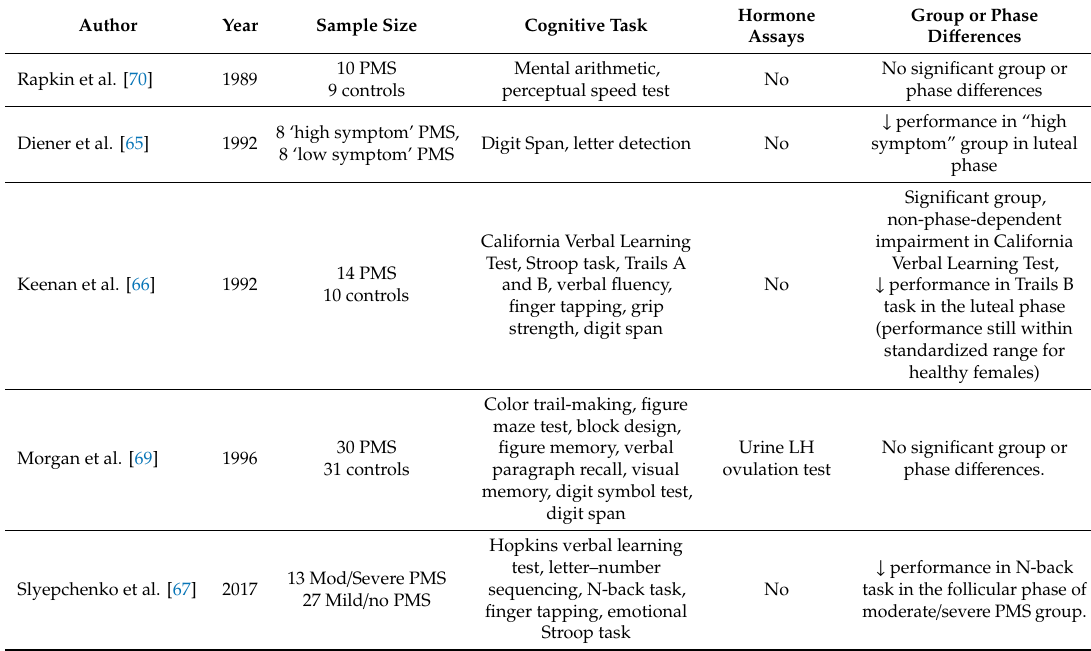
Table 1. Cognitive studies in premenstrual syndrome (PMS).